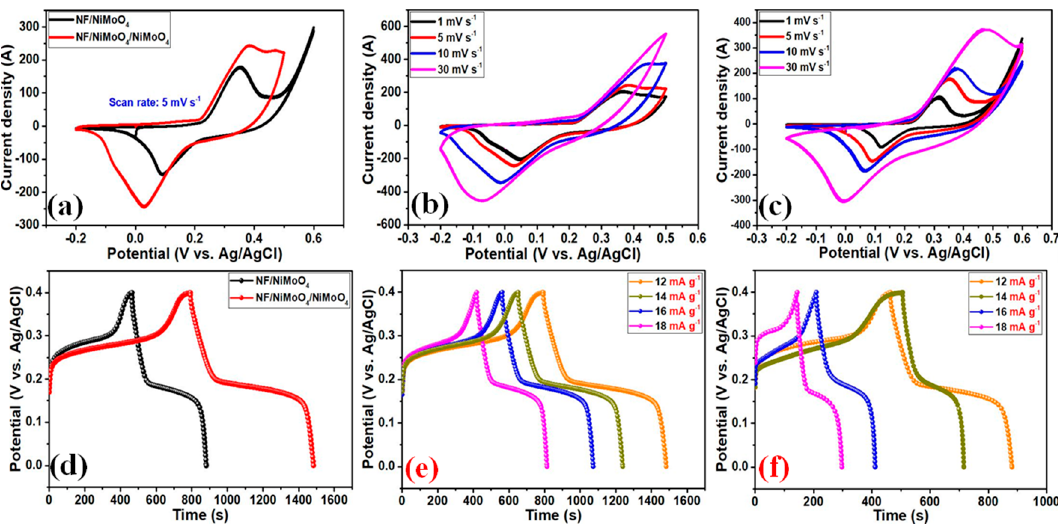
Figure 5. ( a ) Comparison of the CV curves of the NF/NiMoO 4 and NF/NiMoO 4 /NiMoO 4 at the same scan rate (5 mV s − 1 ). ( b , c ) CV curves of the NF/NiMoO 4 /NiMoO 4 electrode and NF/NiMoO 4 electrode at various scan rates. ( d ) GCD curves of the NF/NiMoO 4 and NF/NiMoO 4 /NiMoO 4 electrodes at a current density of 12 mA g − 1 . ( e , f ) Galvanostatic charge-discharge curves of the NF/NiMoO 4 /NiMoO 4 and NF/NiMoO 4 electrodes at different current densities.